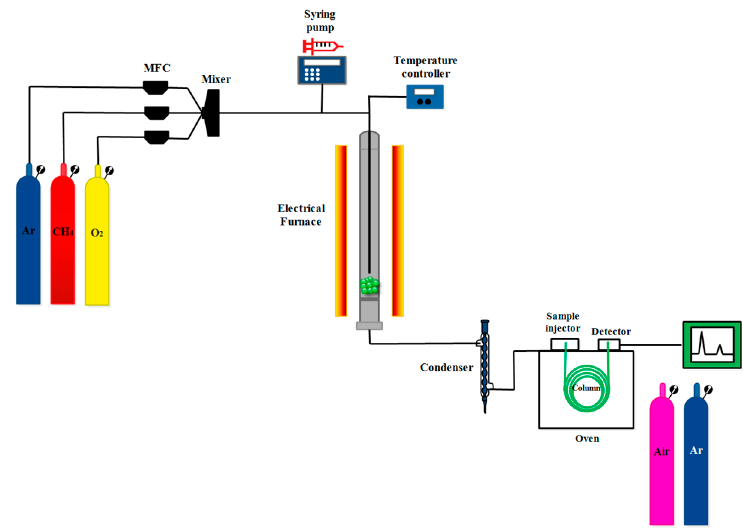
Figure 13. Reactor system for CL ‐ SMR.